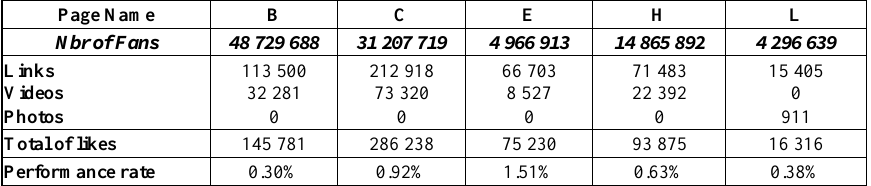
Table 1. Results Analysis of « Likes Buttons » on posts sharing in Facebook